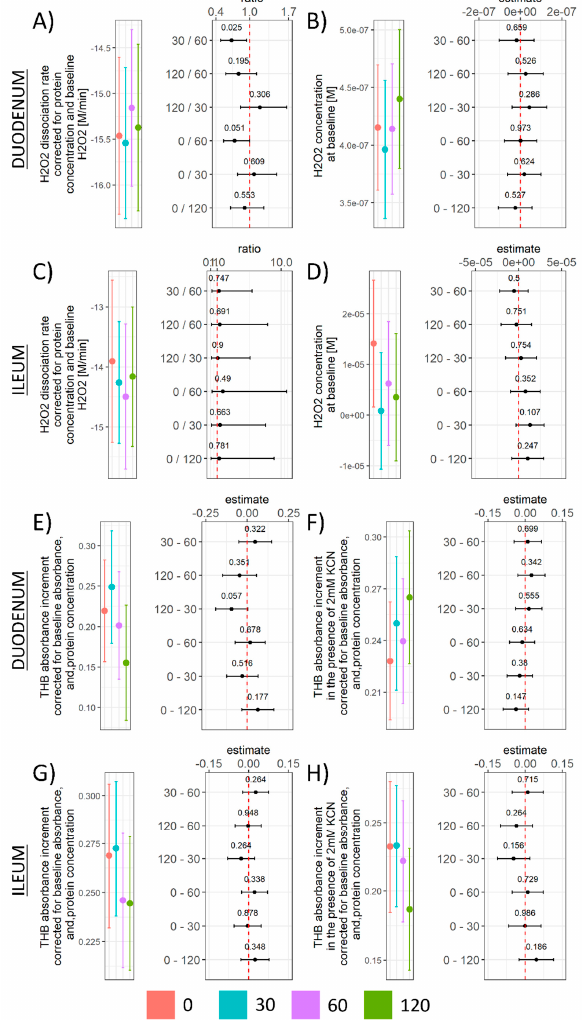
Figure 4. H 2 O 2 dissociation rate, H 2 O 2 concentration at baseline, and SOD activity in the rat duode- num and ileum following acute orogastric gavage of 200 mg/kg D -galactose. ( A ) Duodenum H 2 O 2 dissociation rate model output (group point estimates with 95% confidence intervals) ( left ) and ratios of estimated marginal means for groups with corresponding 95% confidence intervals ( right ). ( B ) Duodenum H 2 O 2 concentration at baseline model output (group point estimates with 95% confidence intervals) ( left ) and differences of estimated marginal means for groups with corresponding 95% confi- dence intervals ( right ). ( C ) Ileum H 2 O 2 dissociation rate model output (group point estimates with 95% confidence intervals) ( left ) and ratios of estimated marginal means for groups with corresponding 95% confidence intervals ( right ). ( D ) Ileum H 2 O 2 concentration at baseline model output (group point esti- mates with 95% confidence intervals) ( left ) and differences of estimated marginal means for groups with corresponding 95% confidence intervals ( right ). ( E ) Duodenum THB absorbance increment